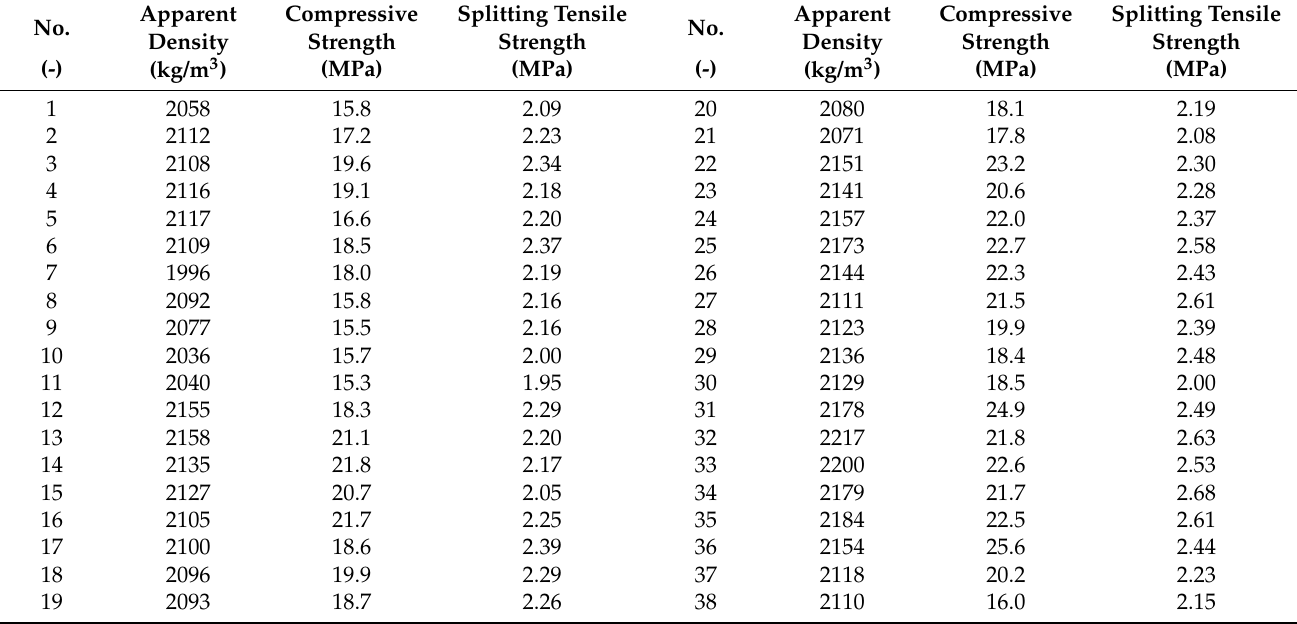
Table 4. Hardened concrete properties—stage II of the